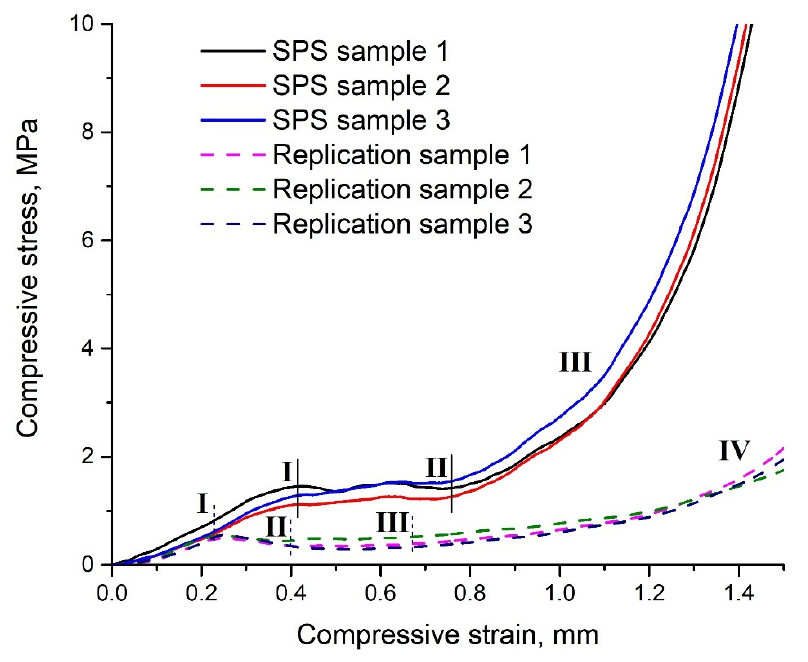
Figure 9. Compression strain curves for aluminum foams: SPS sample, replication sample.